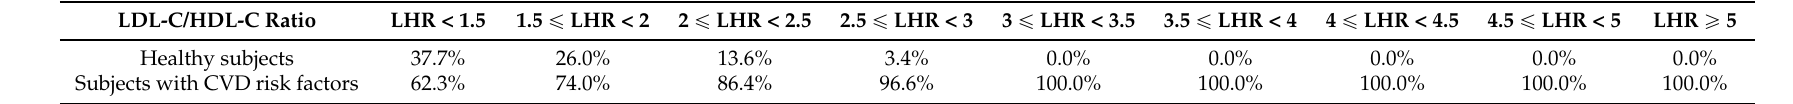
Table 4. The distribution of risk factors stratified by LDL-C/HDL-C ratio category in healthy subjects and subjects with CVD risk